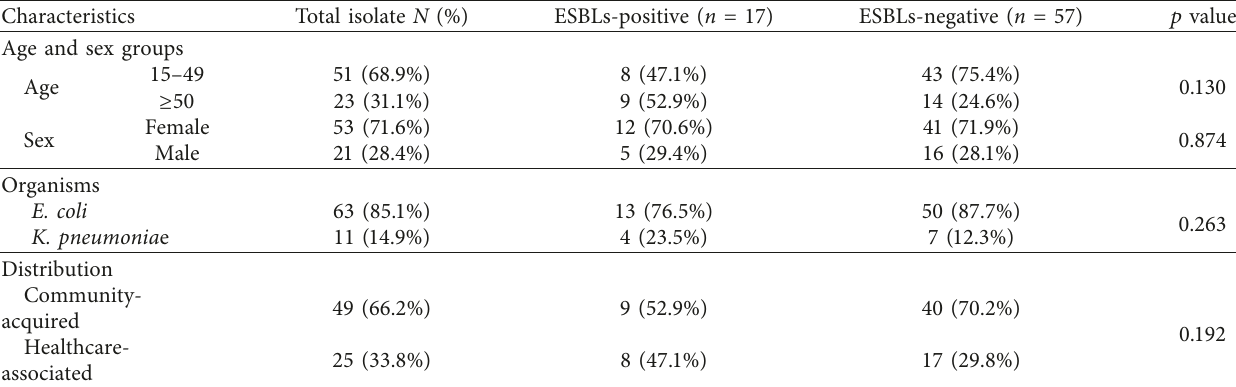
Table 1: Distribution of ESBL-producing and non-ESBL-producing E. coli and K. pneumoniae isolated from community-onset urinary tract infections in JUSH, Southwest Ethiopia,